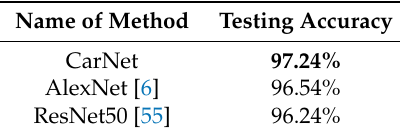
Table 12. Comparisons of testing scores for CarNet, AlexNet [6] and ResNet50 [55] on CNRPark + EXT dataset